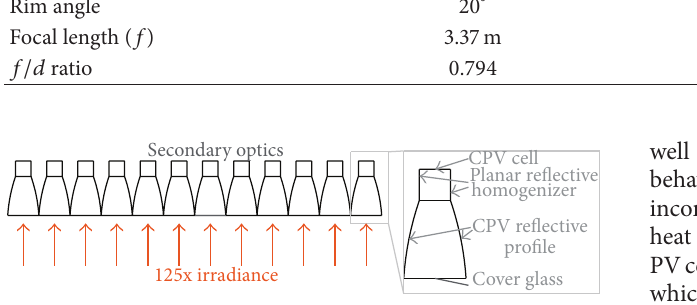
Figure 2: Cross-sectional view of the secondary